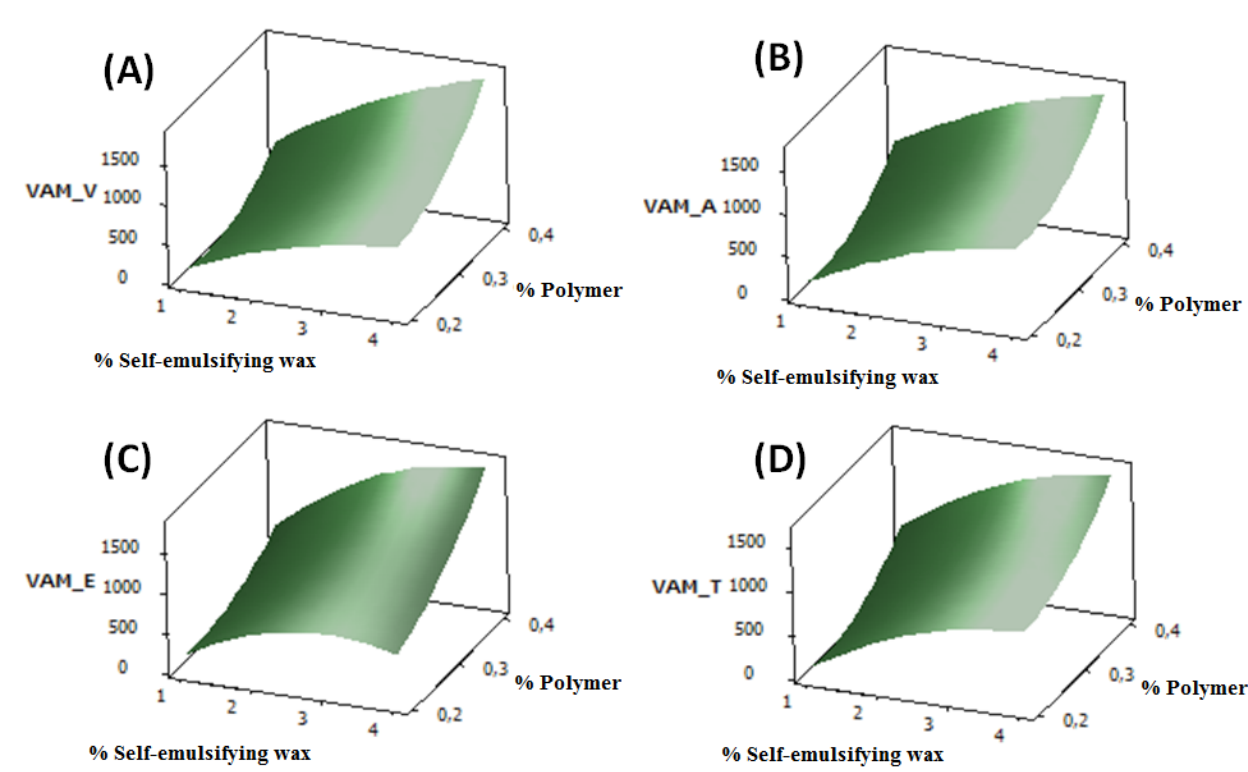
FIGURE 4 - Response surfaces for minimum apparent viscosity (VAM) as a function of the factors: % of self-emulsifying wax and % hydrophilic polymer for the formulations: vehicle (A) containing 0.5% retinyl palmitate (B), 5% tocopheryl acetate (C) and 0.1% tocoretinate